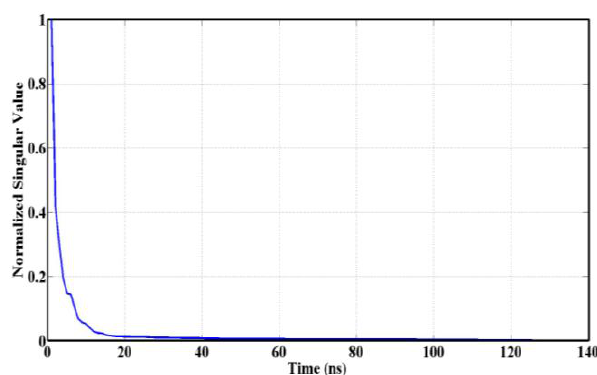
Figure 1. Normalized singular values of the matrix Σ of a given noisy signal